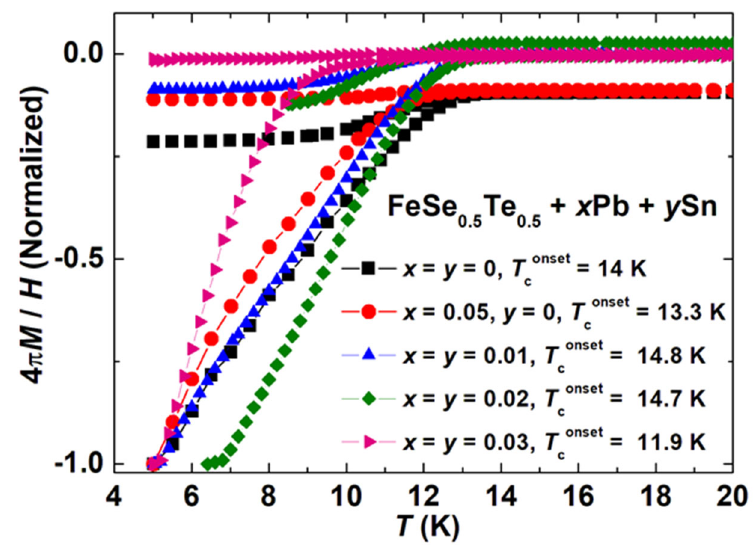
Figure 3. The variation of magnetic susceptibility ( χ = 4 π M / H ) with temperature for various FeSe 0.5 Te 0.5 + x Pb + y Sn ( x = y = 0, 0.01, 0.02, 0.03, and also x = 0.05, y = 0) bulks at the applied magnetic field of 20 Oe under zero-field-cooled (ZFC) and field-cooled (FC) regimes.